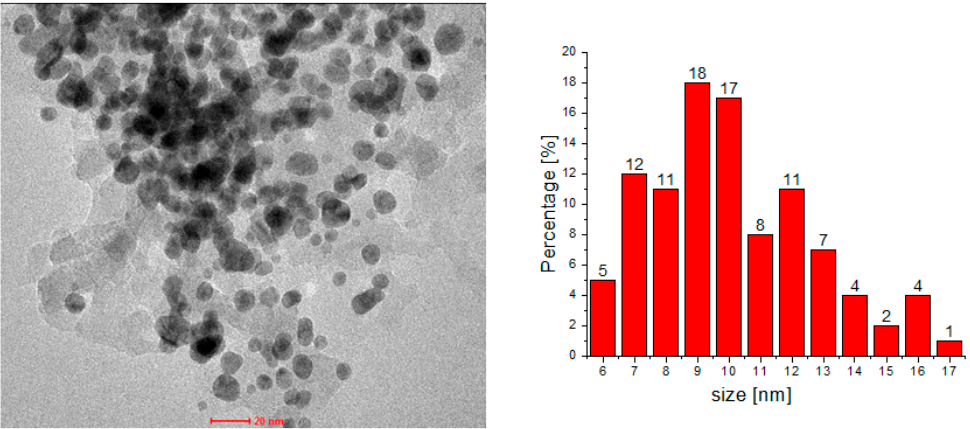
Figure 12. TEM images of C2 after seven catalytic runs and particle size distribution [33].